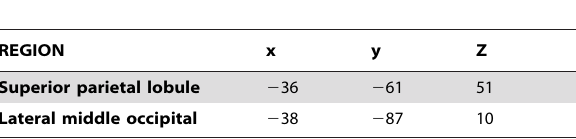
Table 2. Talairach coordinates (in mm) of the vertex showing the maximum difference of source activity for valid versus invalid targets following fearful gaze cues, in the parietal and occipital